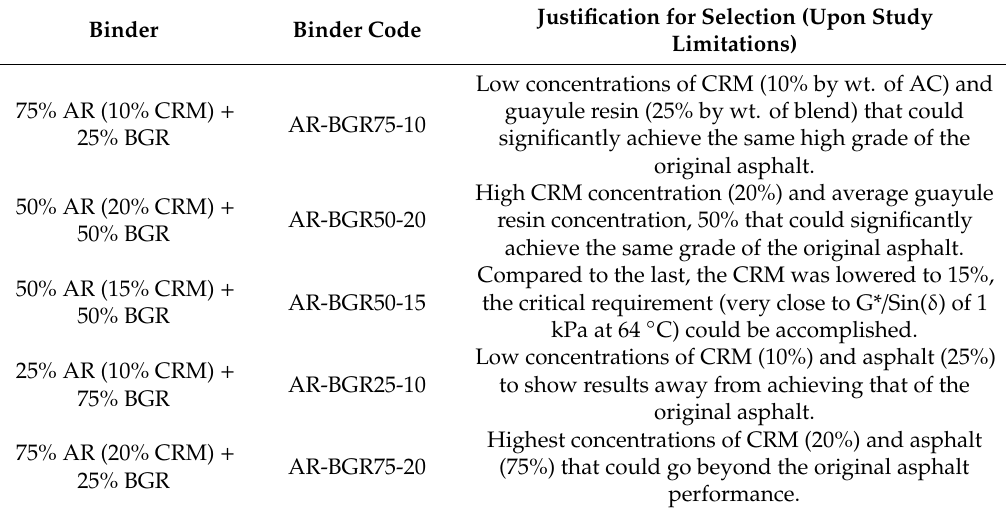
Table 3. Selected binders attributed to the justification for selection. Justification for Selection (Upon Study Binder Code